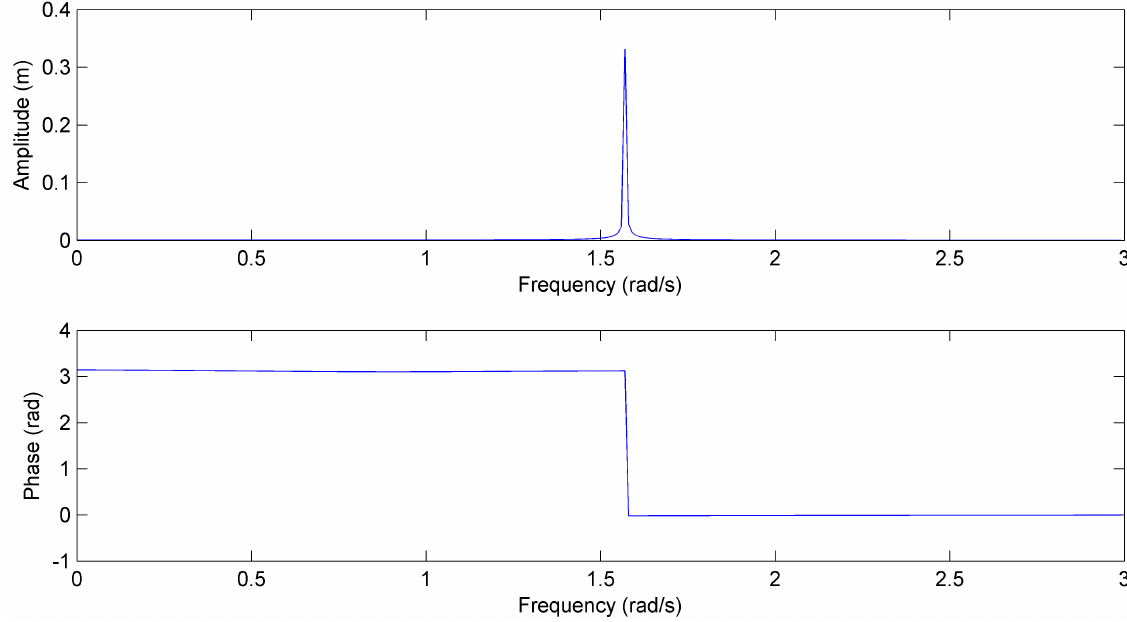
Figure 4: Dynamic response in frequency domain (zero initial conditions). Table 2: Lamina elastic properties (fibre volume fraction: r f = 0.6 ).